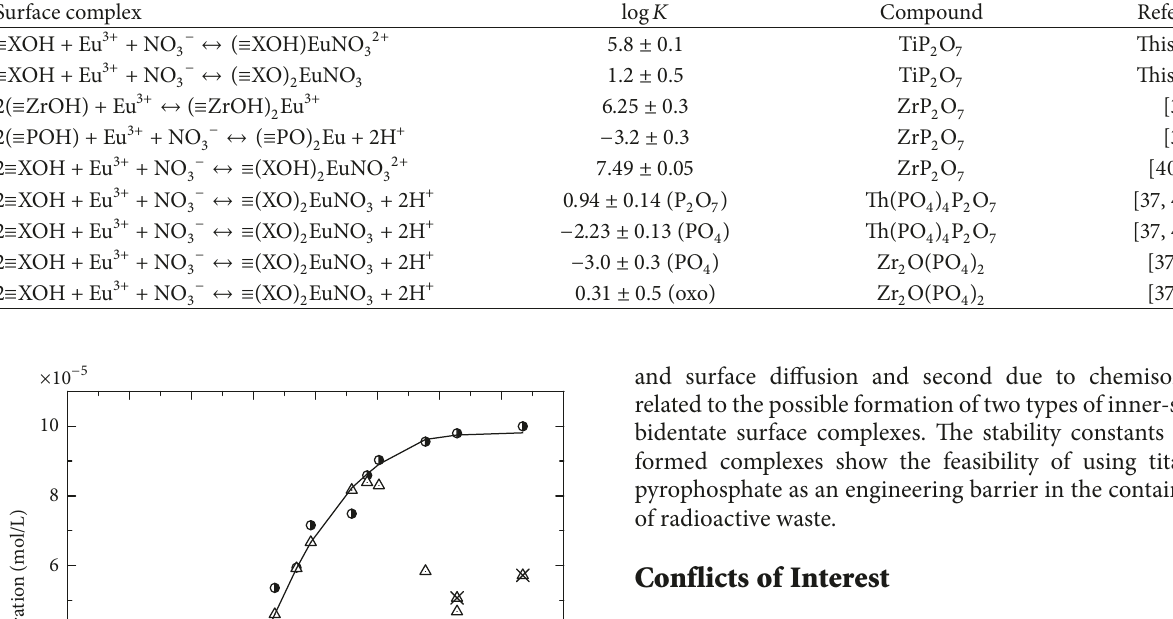
Table 3: Eu (III) sorption equilibria onto titanium pyrophosphate and other compounds and associated constants. Surface complex